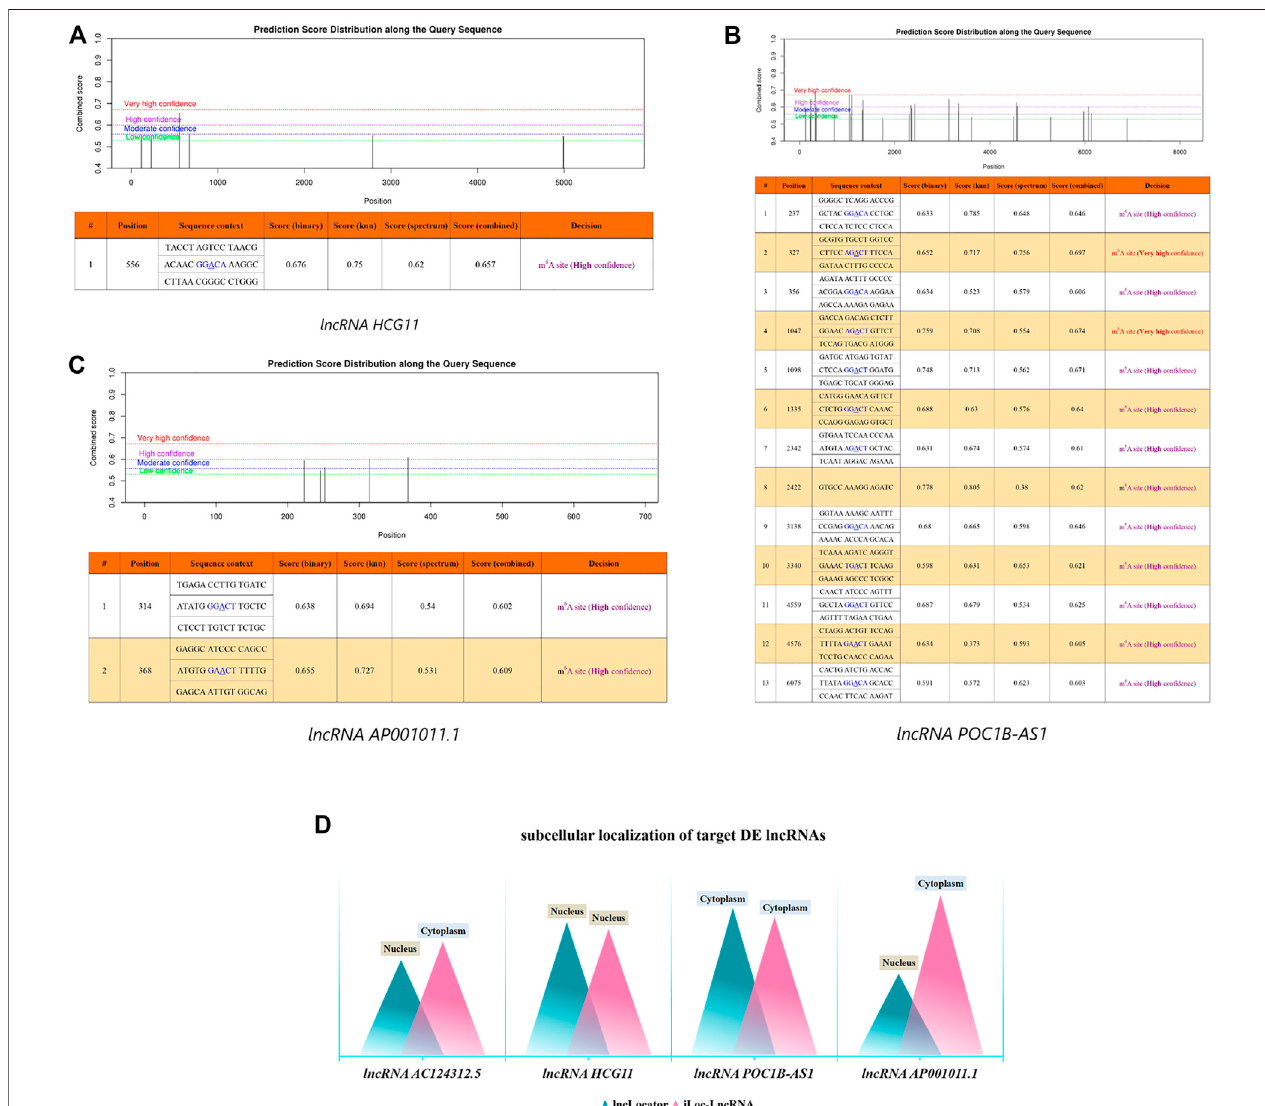
FIGURE 9 | Bioinformatic Analysis of 4 DE LncRNAs. m6A modi fi cation sites prediction analysis of lncRNA HCG1 (A) , lncRNA POCIB-AS1 (B) and AP001011.1 (C) . (D) Subcellular localization prediction analysis of 4 DE lncRNAs. DE, differentially expressed.